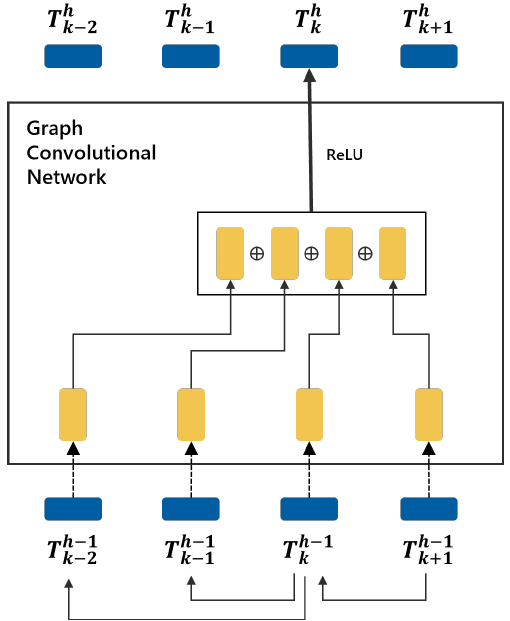
Figure 3. Example of node propagation in the h -th GCN layer.